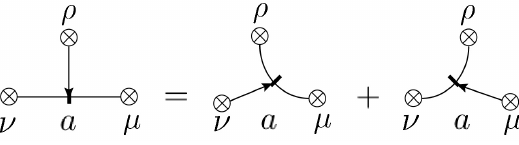
Figure 20 . A graphic interpretation of the relation F µν verified